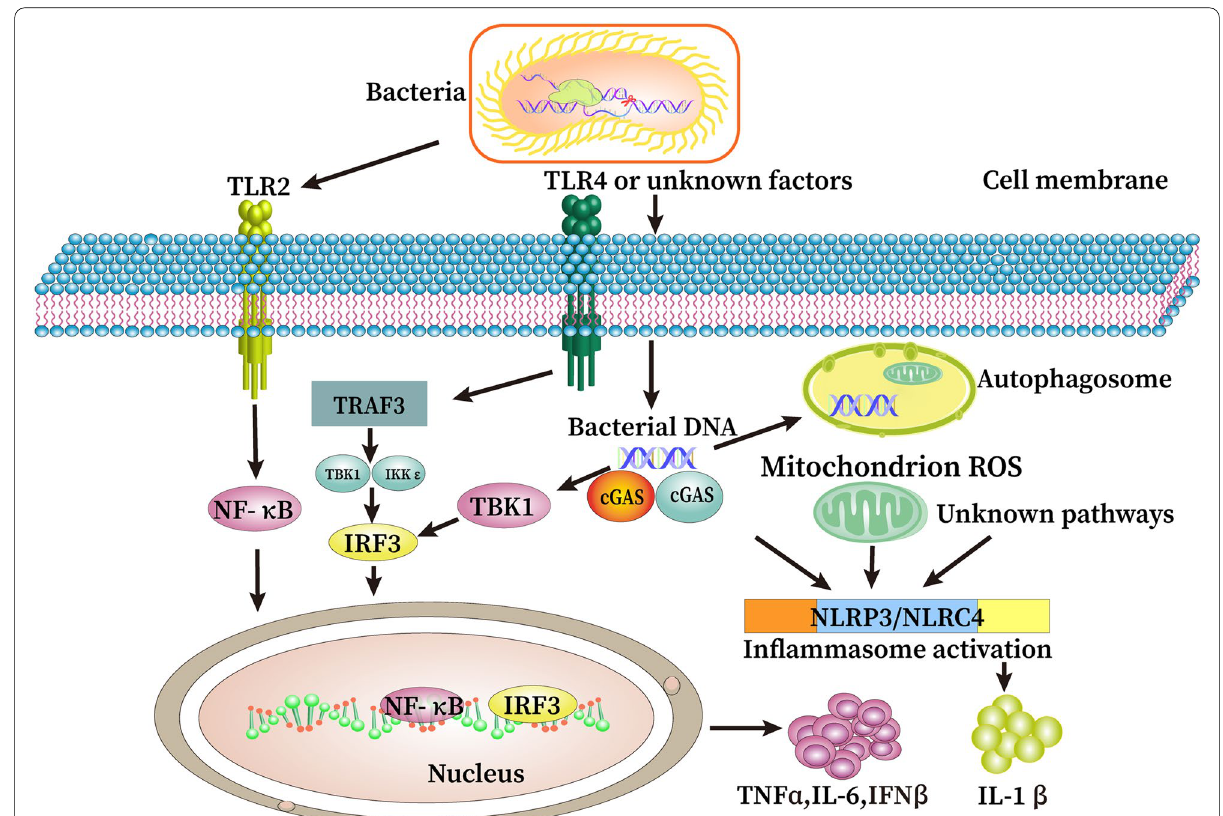
Fig. 4 CRISPR-Cas impacts host defense by regulating several signals involving innate immunity and inflammatory responses. CRISPR-Cas may participate in the recognition of pattern recognition receptors (PRRs) (e.g., TLR2, TLR4 or other unknown PRRs) and the activation of their downstream signaling pathways. The downstream effects include altered levels of mitochondrion ROS, inflammasome, autophagy, depletion of CRISPR-Cas in P. aeruginosa strain PA14 leads to exaggerated inflammation and organ damage through rapid nuclear translocation of the transcription factor NF-κB after PRRs